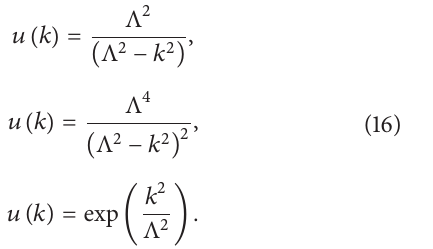
Table 3: Self-energy of a nucleon, 𝛿𝑚 𝑁 , in dimensional regulariza- tion ( 𝑀𝑆 ) scheme, as a function of renormalization scale 𝜇 . 𝛿𝑚 𝑁 (GeV) 𝜇 (GeV) 𝜃 = −18.5